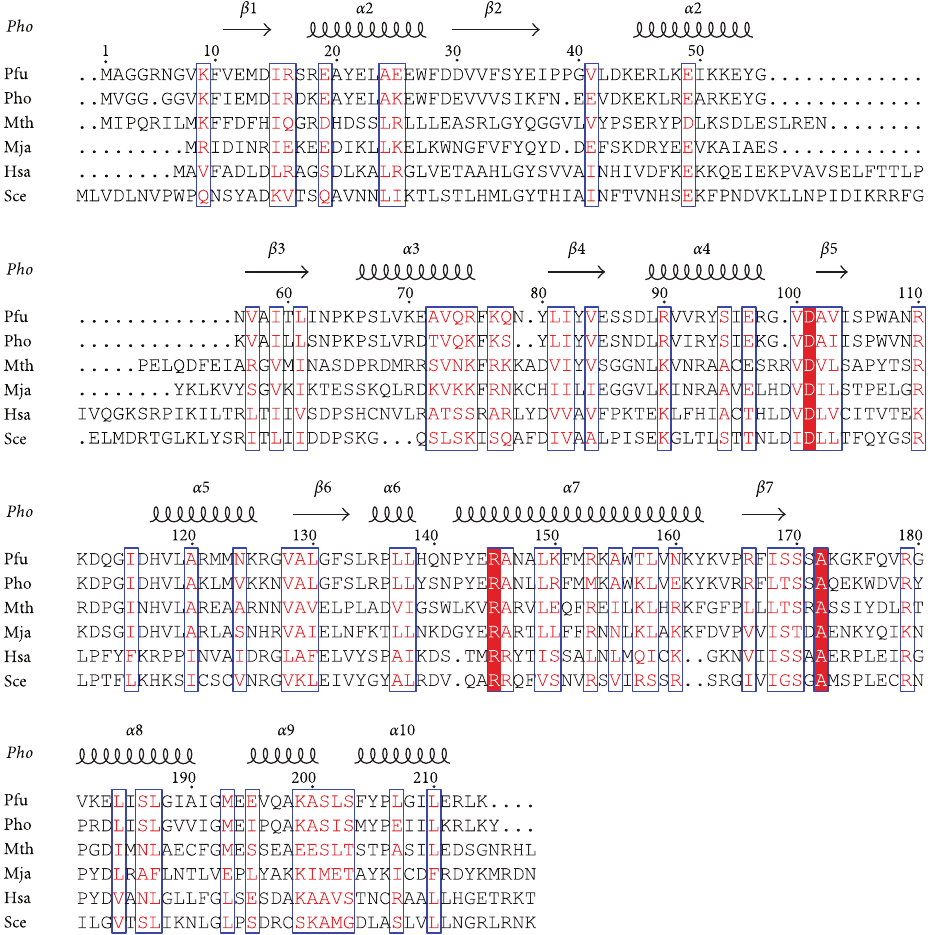
Figure 1: Sequence alignment of RPP30 homologs from four archaea, Pyrococcus furiosus ( Pfu ; NP 579643) , Pyrococcus horikoshii ( Pho ; NP 143706) , Methanothermobacter thermautotrophicus ( Mth ; NP 275831) , and Methanocaldococcus jannaschii ( Mja ; NP 248131) and two eukaryotes Homo sapiens ( Hsa ; NP 006404) and Saccharomyces cerevisiae ( Sce ; NP 011929). Block letters indicate invariant residues and boxes indicate residues with a global similarity score > 0.7. The secondary structure observed in the homologous Pho crystal structure [14] is depicted above the alignment. Alignment was performed using CLUSTALW [15] and colored according to similarity with a Risler scoring matrix [16] using the program ESPript